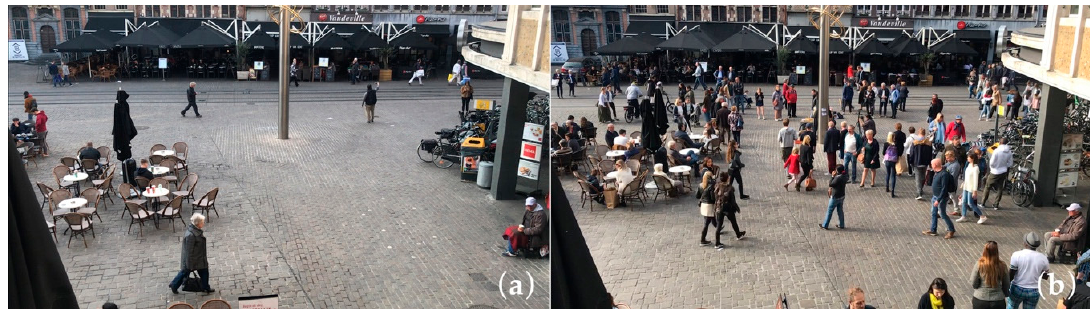
Figure 5. Comparison of the pedestrian density on Monday ( a ) and on Saturday ( b ).